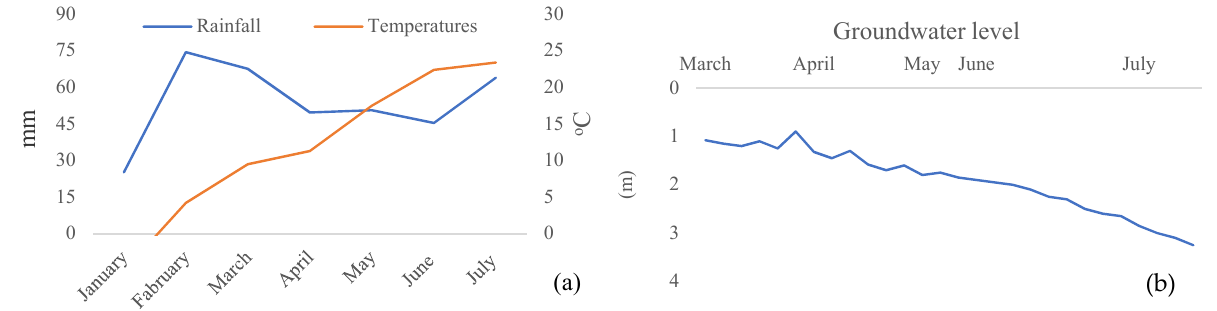
Figure 3. Rainfall (mm) and air temperatures (°C) (a), and groundwater level (b) during the January–July period.